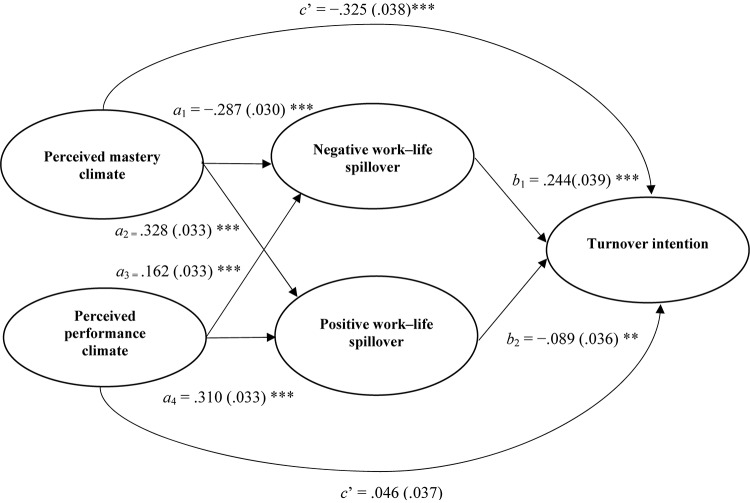
Results of the predicted mediation model. The figure gives a simplified presentation of the tested model. The numbers in parentheses are standard errors. a, influence of independent variable on mediator; b, influence of mediator on dependent variable; c’, direct influence. **p < 0.01 and ***p < 0.001.